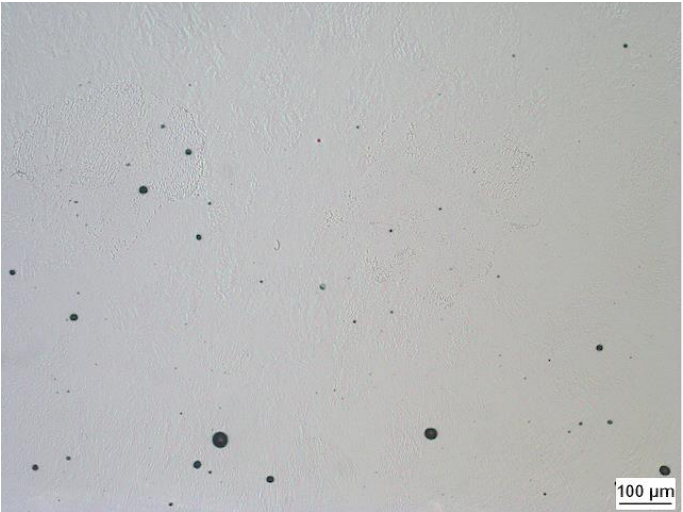
Figure 9. Optical micrograph of 5_C specimen showing porosity. Specimens were chemically etched in order to reveal the microstructure of the material. An interesting result concerns the difference between the microstructure in the first layer and in the successive layers of the heat-treated specimens. Micrographs show that Cr dis- persion affected negatively the treatability of the material. The martensitic transformation that occurred by precipitation of intermetallic compounds was clearly visible in all the coating layers except in the first one (Figure 10). Only very few retained austenite areas were visible. It was also possible to observe that the metallurgical interface was regular and free of significant defects (see Figures 10 and 11). Discontinuities like lack of fusion